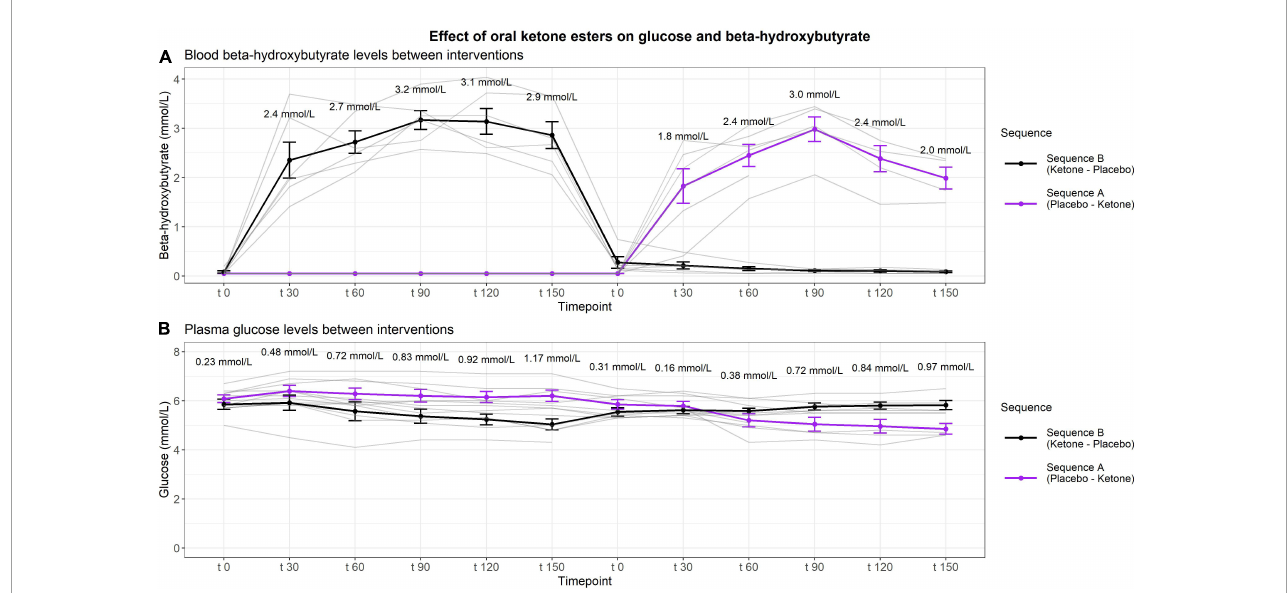
FIGURE2 Effect of ketone esters on BHB and glucose levels. The figure depicts the changes in BHB levels assessed from whole blood and shows the average peak BHB-levels at the different timepoints (A) and depicts the absolute changes in glucose assessed from plasma (B) between interventions given as mean ± SEM. Data was analyzed by general linear mixed model adjusted for time of day, t0 and interaction between timepoints and intervention. Blood samples were collected at six timepoints every half hour from t0 to t150 for morning and afternoon, respectively.